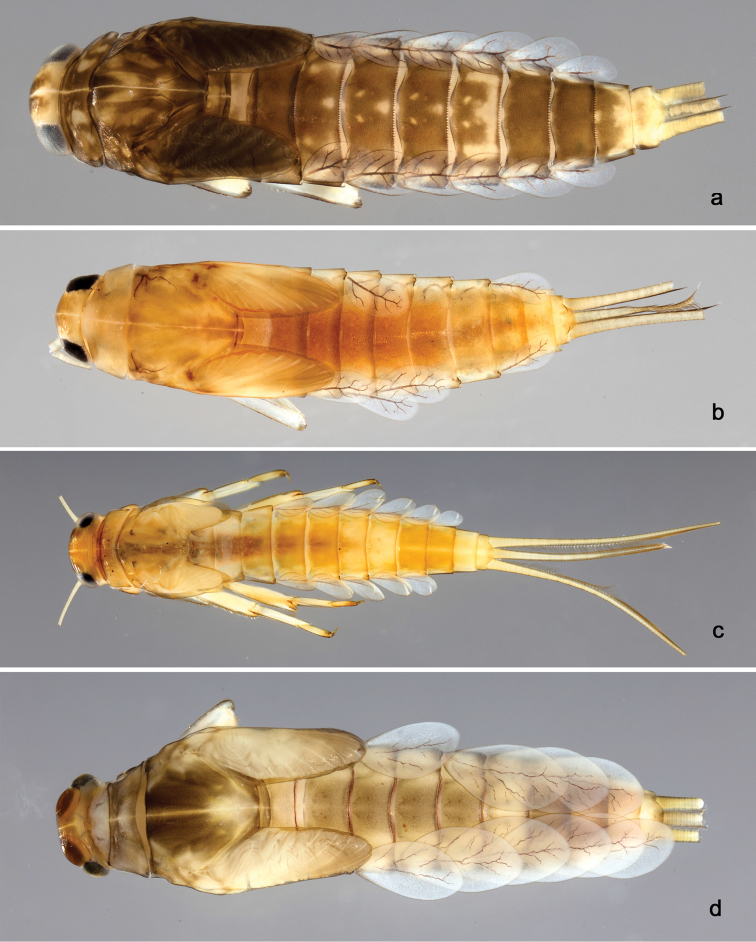
Habitus, larvae: aLabiobaetisstagnum sp. n., dorsal view bLabiobaetispapuaensis sp. n., dorsal view cLabiobaetisgladius sp. n., dorsal view dLabiobaetisjanae sp. n., dorsal view.